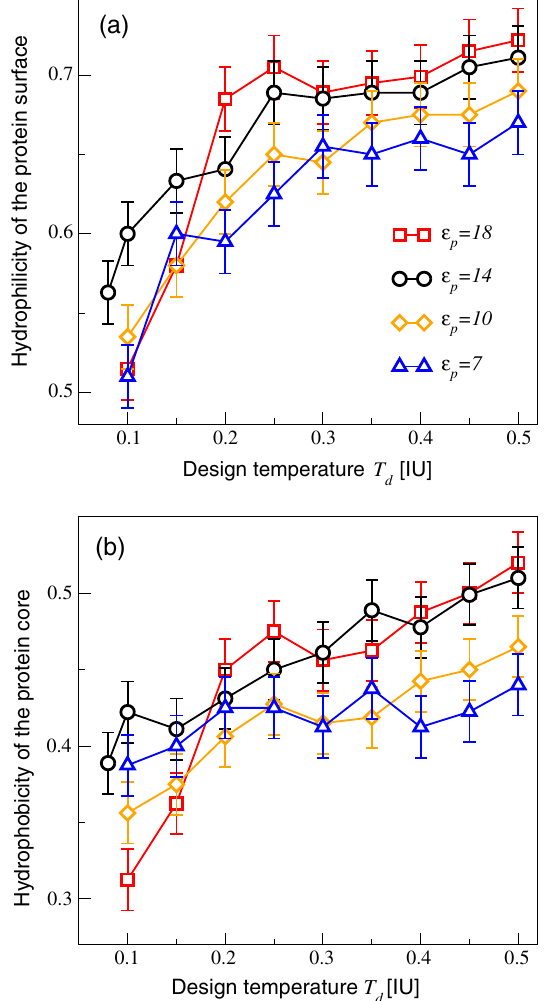
FIG. 8. Hydropathyprofileofproteinsdesignedatambientpressurefordifferentvaluesof ϵ p .Here,wereporthowthehydrophilicprofileof the protein surface and the hydrophobic profile of the protein core, respectively shown in panels (a) and (b), changes as a function of T d , at ambientpressure,accordingtotheparameter ϵ p ,appearinginEq.(B1).ThedataarecalculatedfollowingtheprotocolMINENTHALPY.Inall cases, the segregation between the hydrophilic surface and the hydrophobic core decreases with T .